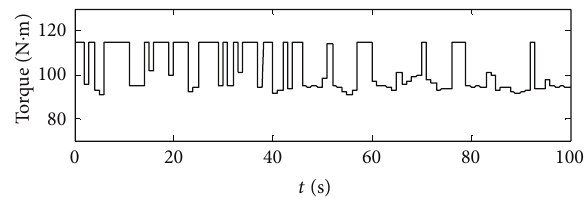
Figure 7: A group of optimized torque demands for the engine.